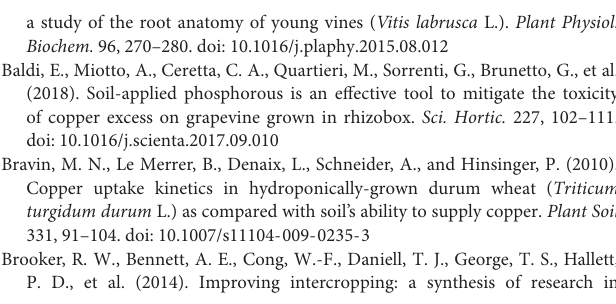
FIGURE S1 | Representative root apparatus of the Fercal rootstocks at 25 µ M Cu (a) showing the characteristic thickening of root tips caused by Cu toxicity (b) . A representative root tip of a Fercal rootstock grown without toxic Cu concentrations (i.e., 0.2 µ M Cu) is also shown (b) . FIGURE S2 | Phylogenetic tree of NRAMP genes. FIGURE S3 | VvCTr genes expression determined in root apexes of monocropped Fercal (a) and 196.17 (b) rootstocks plants grown at 0.2 µ M Cu. The data were normalized to two internal controls, the Elongation Factor 1 α and the tubulin. The relative expression ratios were calculated using VvCTr1 as calibrator. The values reported are means ± SE ( n = 3). TABLE S1 | Sequences of primers used for the